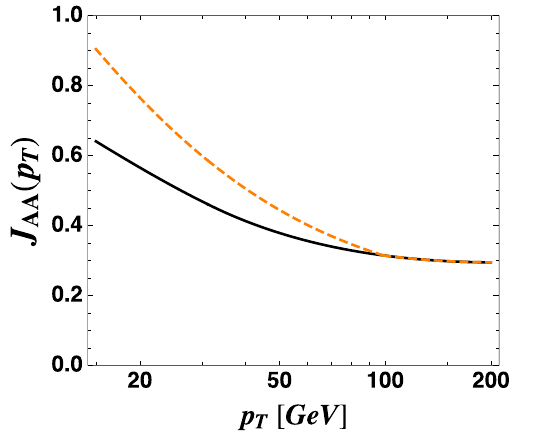
Fig. 3 The ratio Eq. (35) as a function of energy for a light quark (charm, m = 1 . 3 GeV) (solid, black line) and heavy quark (bottom, m = 5 GeV) (dashed, orange line). On the left we have used only the